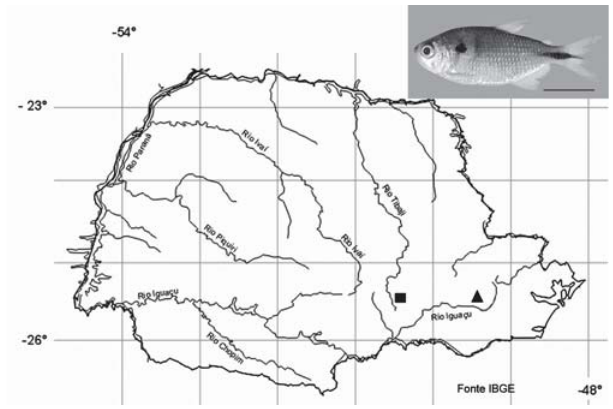
Fig. 1. Paraná State hydrographic map showing the Astyanax altiparanae collection sites. Lagoa Tarumã in the upper rio Tibagi, Ponta Grossa, Brazil (square) and Fazenda Canguiri in the upper rio Iguaçu, Curitiba, Brazil (triangle). A. altiparanae is illustrated in detail. Bar =